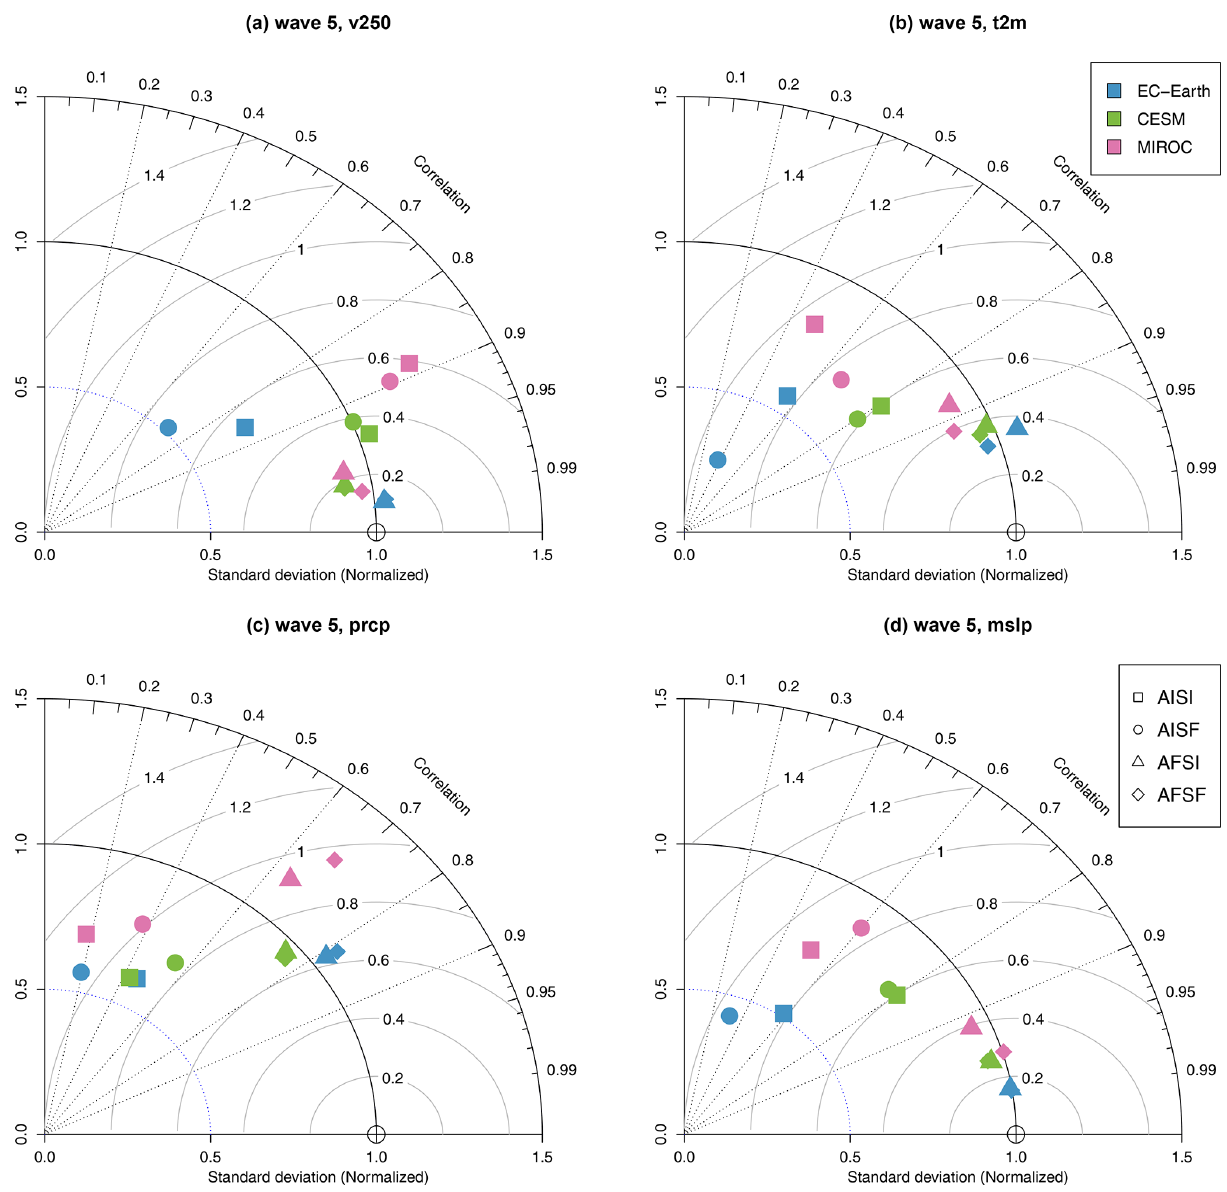
Figure 5. Taylor diagram for all experiments in models compared to ERA5 for wave-5 events and episodes. For (a) v250, (b) t2m, (c) prcp, and (d) mslp, the Taylor diagram presents three statistics for each model and each experiment: the Pearson correlation (dashed lines), the RMSE (gray contours), and the normalized spatial standard deviation (solid black